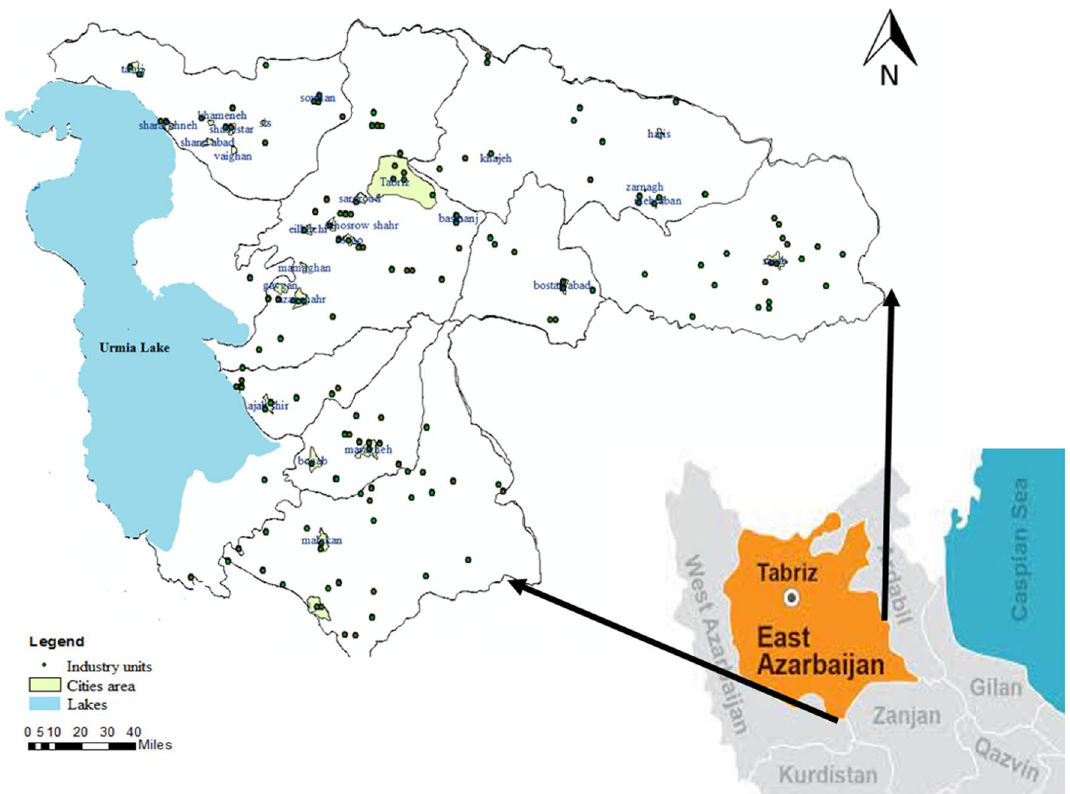
Figure 1. Location of the study area and the distribution of industry units (ArcGIS 10.7.1).